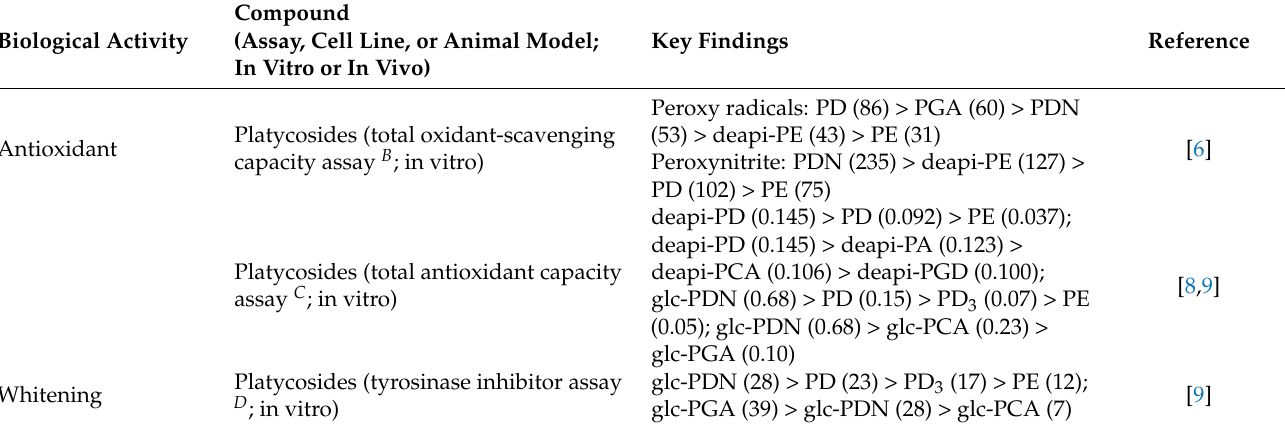
Table 2. Biological activity of